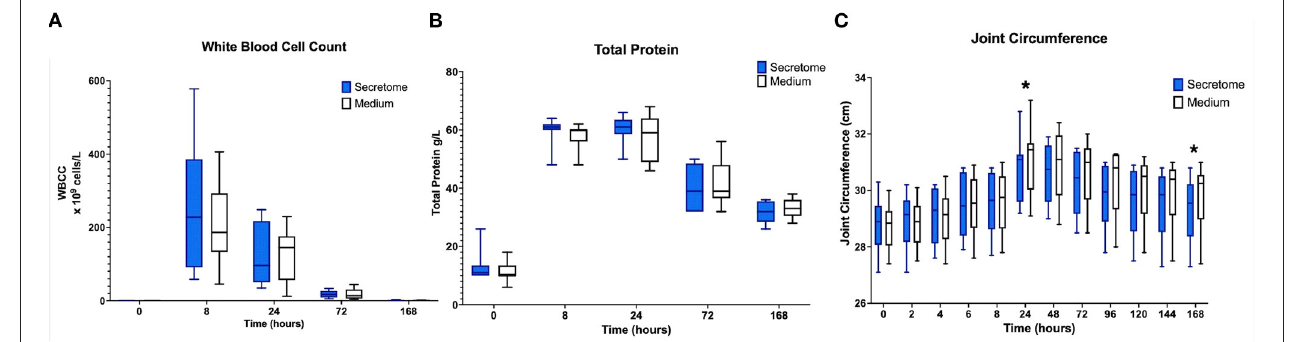
FIGURE 2 | Phase 1 synovial white blood cell counts, total protein, and joint circumference. (A) Synovial White Blood Cell Count, (B) Synovial Fluid Total Protein, and (C) Joint Circumference over time following induction of inflammation with intra-articular injection of 0.25 ng of LPS in the left and right radiocarpal joints of horses at PIH 1 0 ( n = 8 horses). Joints were treated with either intra-articular mesenchymal stem cell (MSC) secretome or medium (negative control) at PIH 1 2. Boxes depict median and interquartile ranges; whiskers denote minimum and maximum values. For the Synovial White Blood Cell Count, the box and whiskers for the first timepoint are not visible on the graph as the values for these were very low with each measurement recorded being < 1 × 10 9 cells/L. * p < 0.05, indicating time points where there are significant treatment